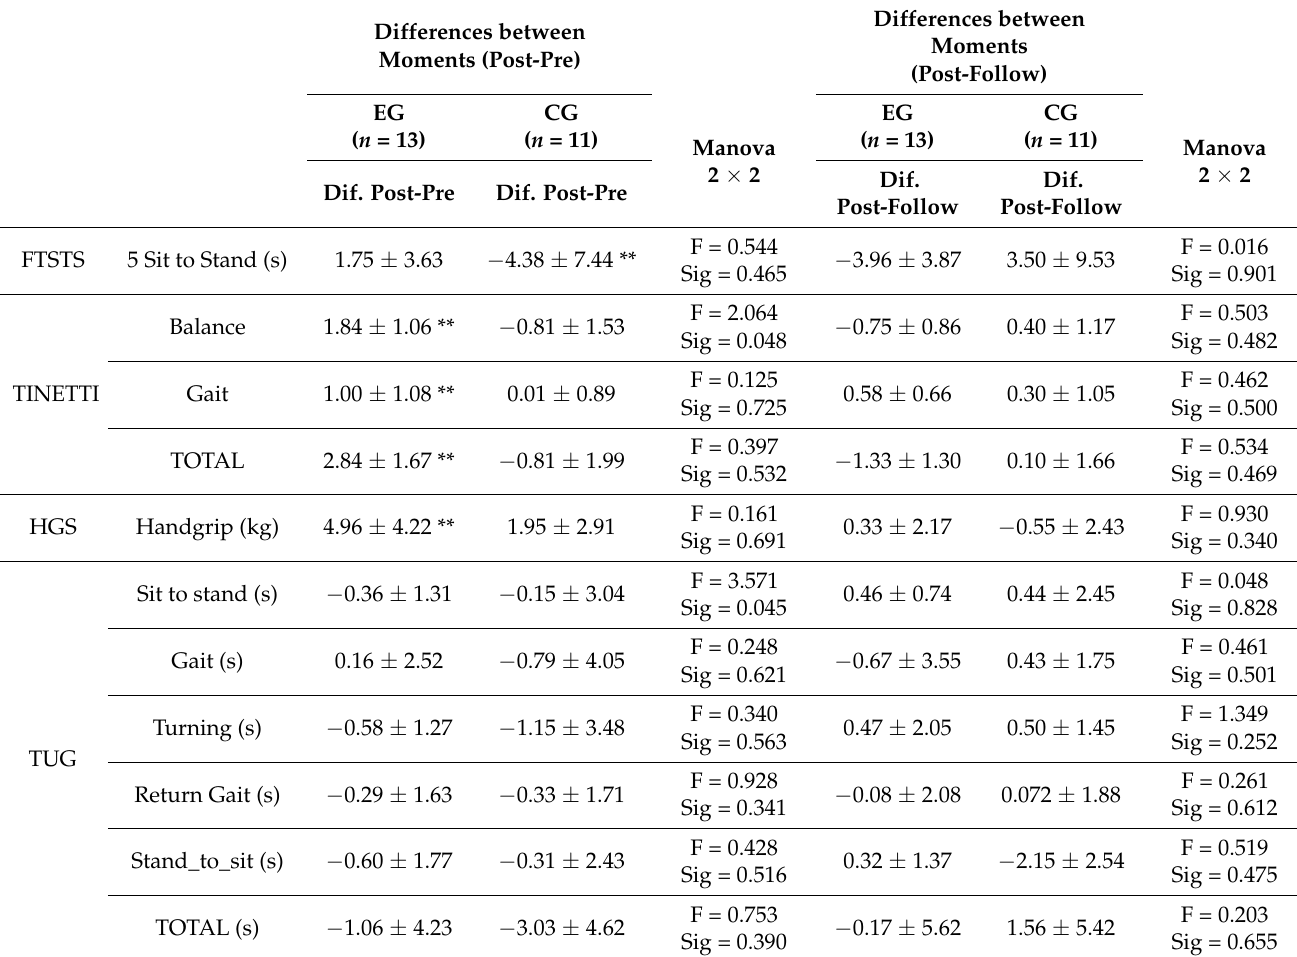
Differences between Moments